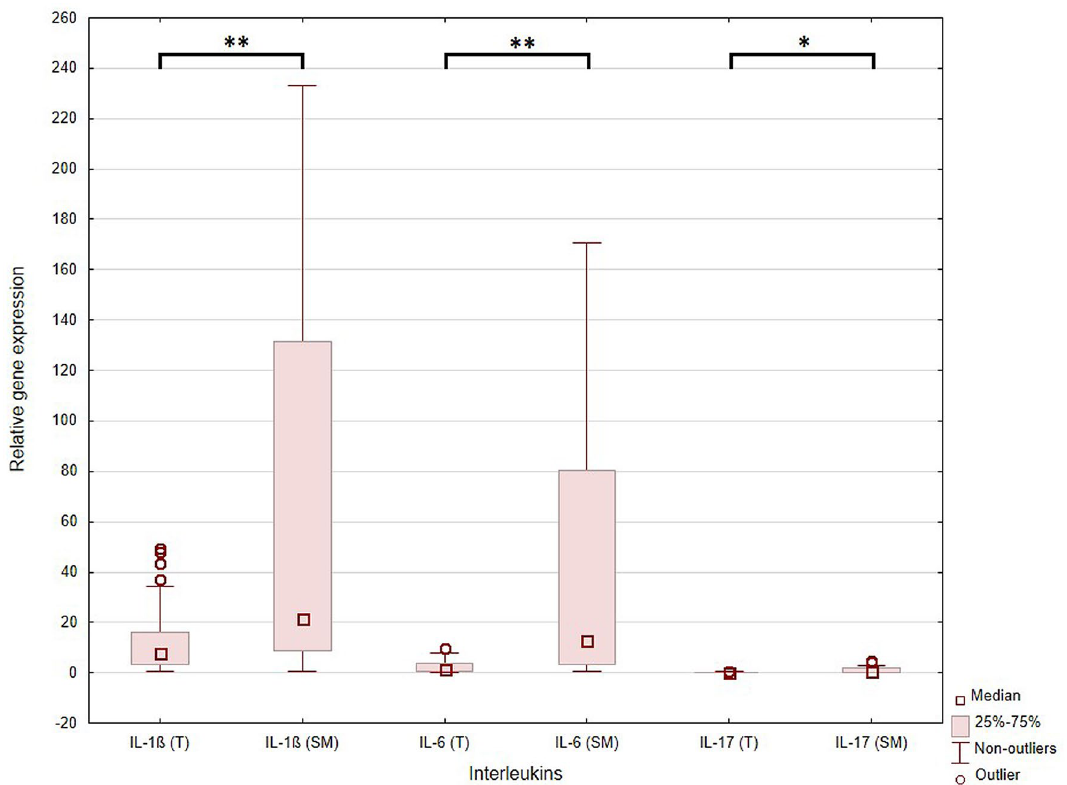
Figure 1. The relative expression of the examined interleukins : IL-1β , IL-6 , and IL-17 assessed in the tumour tissue sample (T) and in the surgical margin (SM). The dependences between each interleukin in both samples were statistically significant: * p = 0.008, ** p < 0.001 (Wilcoxon test). Relative expression (RQ) value, adjusted to ACTB gene (endogenous control) expression